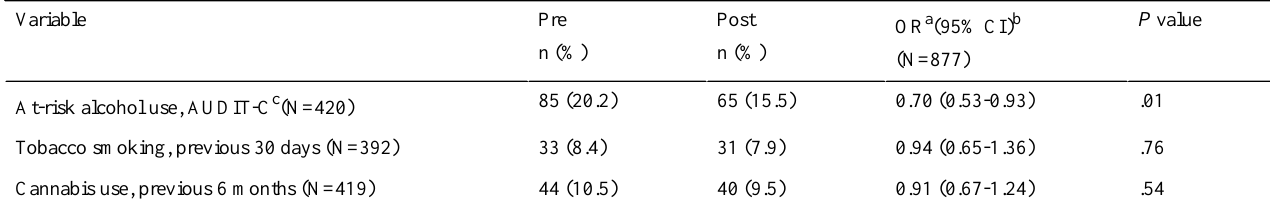
Table 3. Pre-post comparisons of variables addressing substance